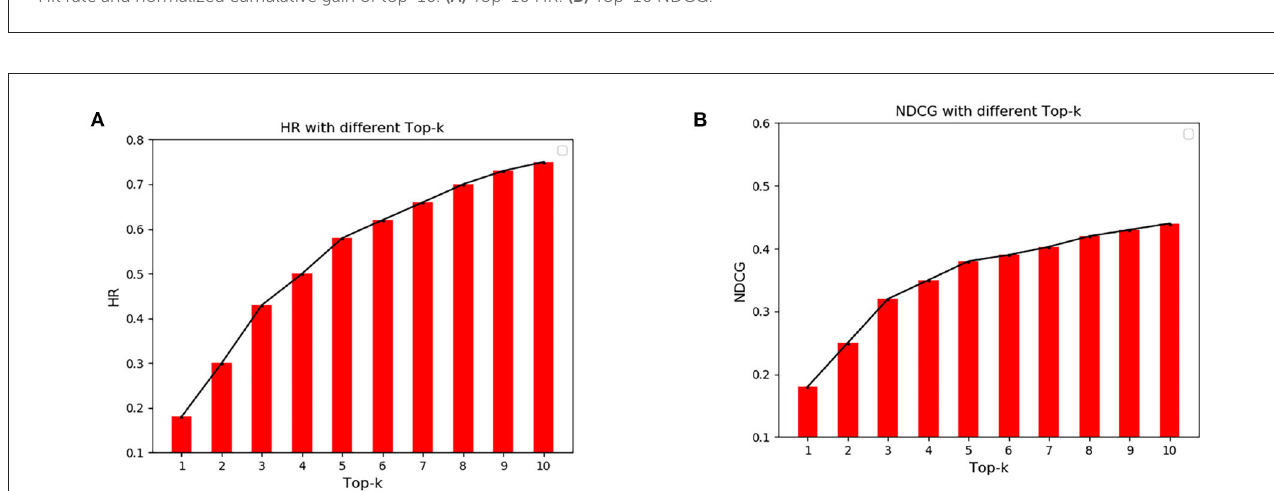
FIGURE7 Cumulative Gain of Hit Rate and Normalized Discount at different top-K. (A) Hit rate under different top-k. (B) Cumulative increase of normalized loss for different